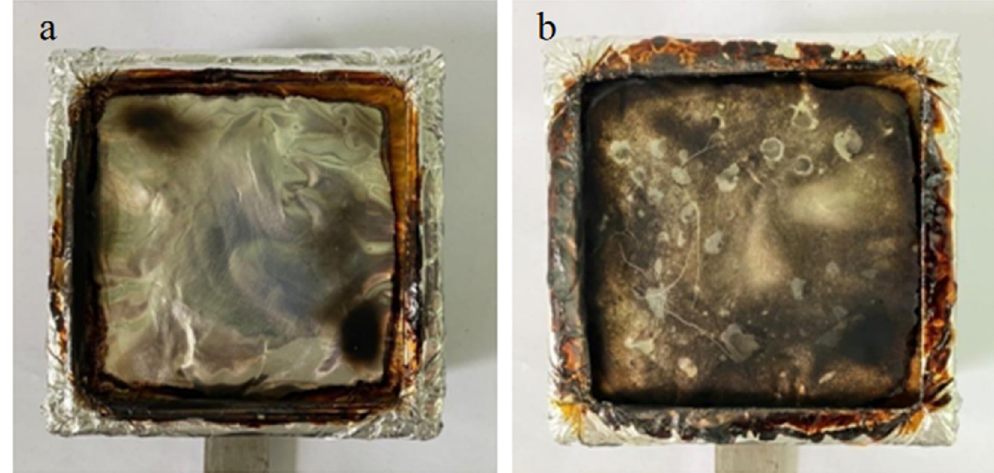
Figure 6: Digital photos of the char residues of EVA ( a ) and its composites ( b ) .